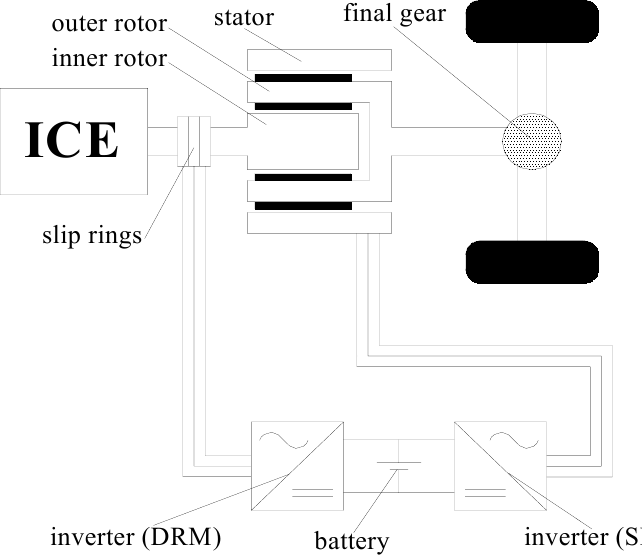
Figure 1. CS-PMSM